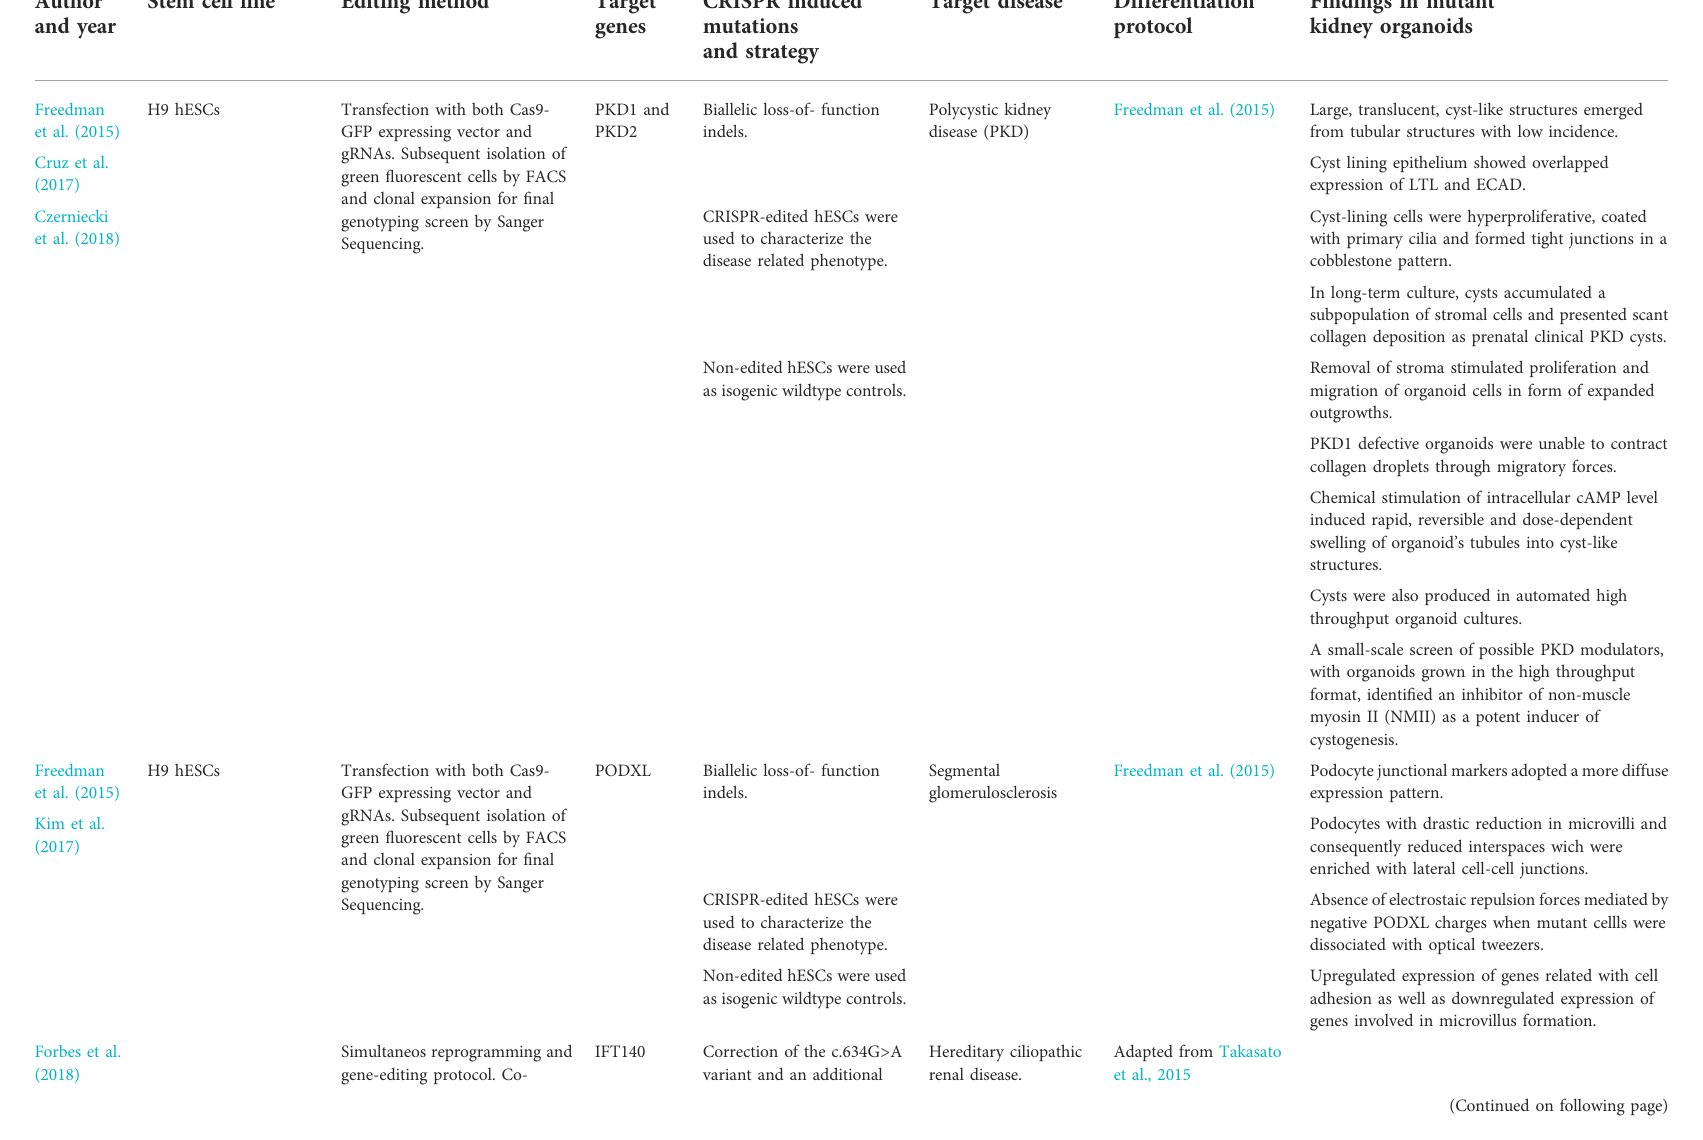
TABLE 2 Published work about disease modelling combining kidney organoids and CRISPR genome